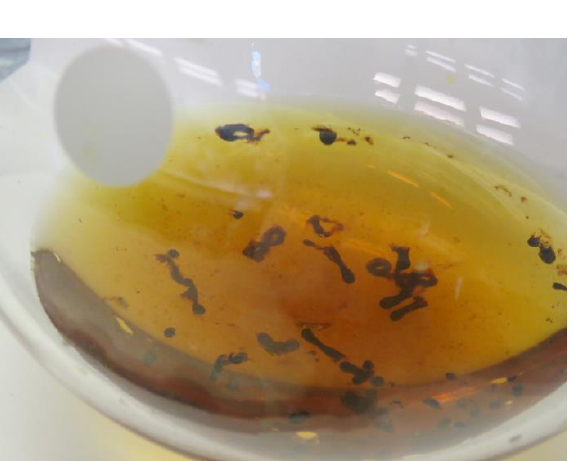
Figure 5 . Iron oxide clumps observed during synthesis using conventional chemical coprecipitation with the addition of 0.4 M NaOH (aq) to an iron salt solution (90 mM ∑Fe).